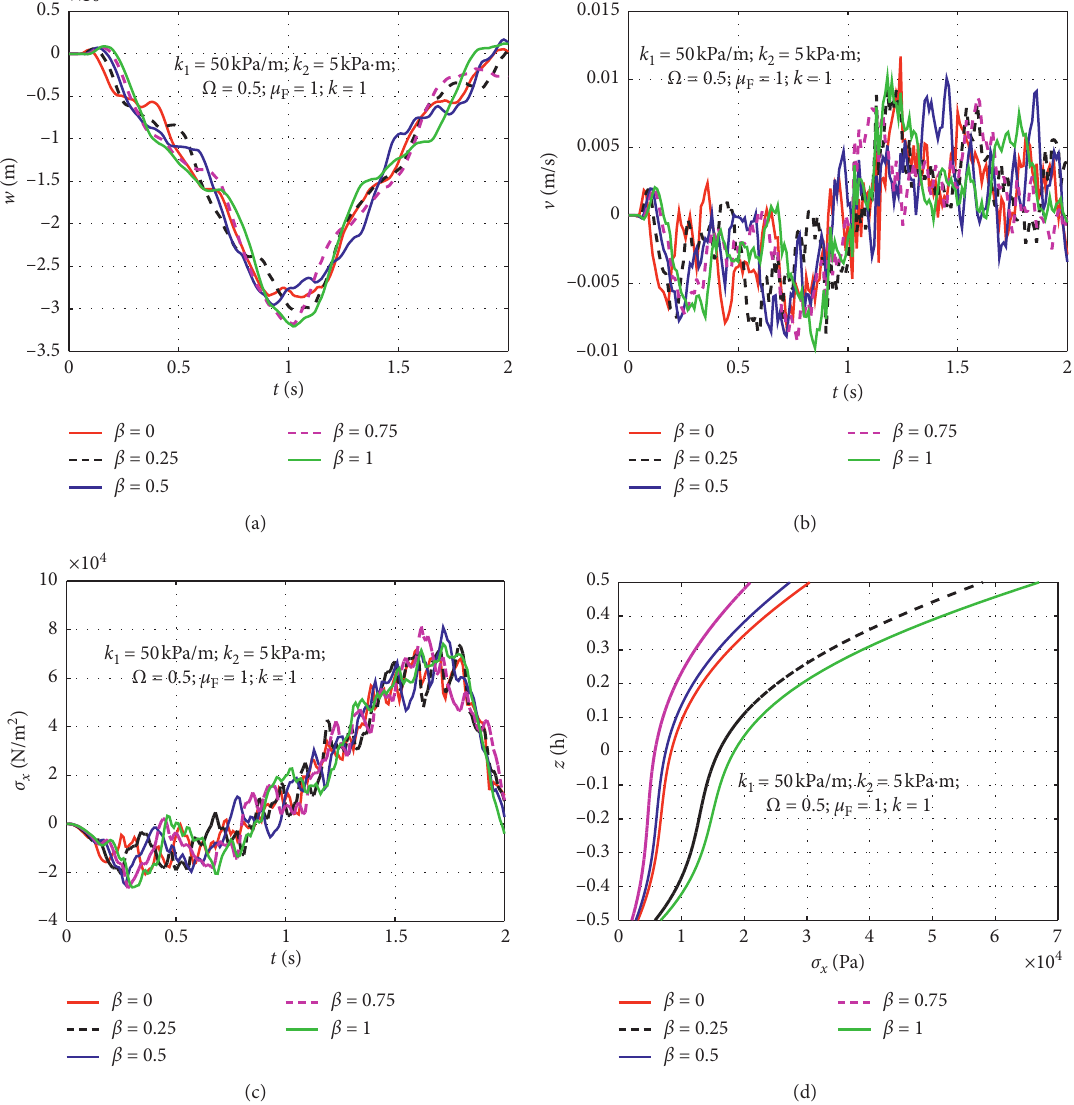
Figure 12: The responses of deflections, velocities, and stresses at the central point of the FGP plate versus time with the variation of mass of the foundation β ; (a) deflection w versus time; (b) velocity v versus time; (c) stress σ x versus time; (d) stress σ x through thickness. Table 8: Maximum deflections, velocities, and stresses at the central point of the FGP plate versus time. Maximum values β �